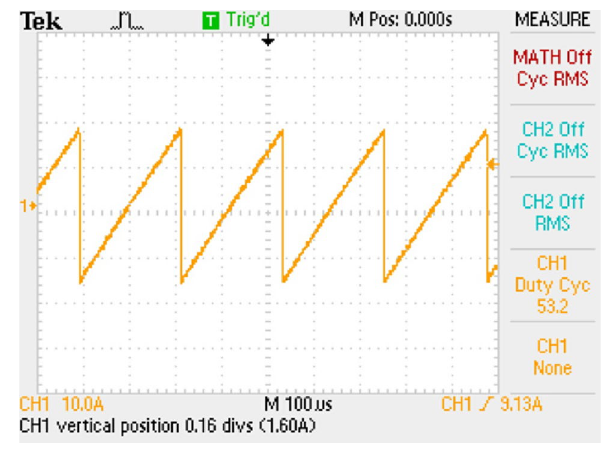
Fig. 9 Sawtooth waveform